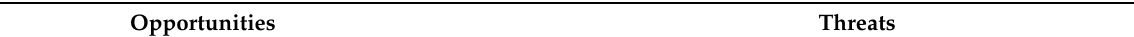
Table A2. Opportunities and Threats (SWOT) of biomass supply chains with respect to mobilizing and placing biomass to the